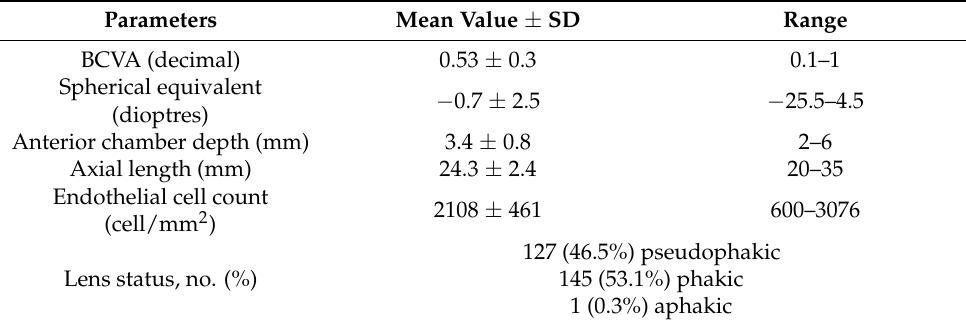
Table 2. Baseline ophthalmological data in the XEN-GTR.